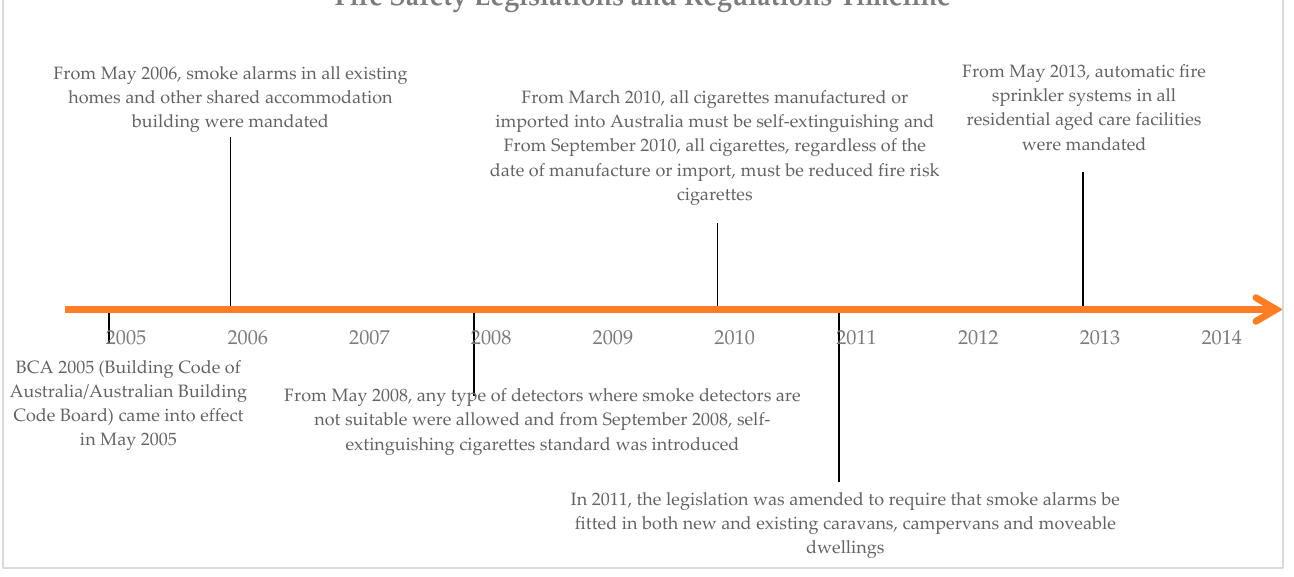
Figure 1. Fire safety legislation and regulations, and changes in Australian building codes in NSW from 2005 to 2015.